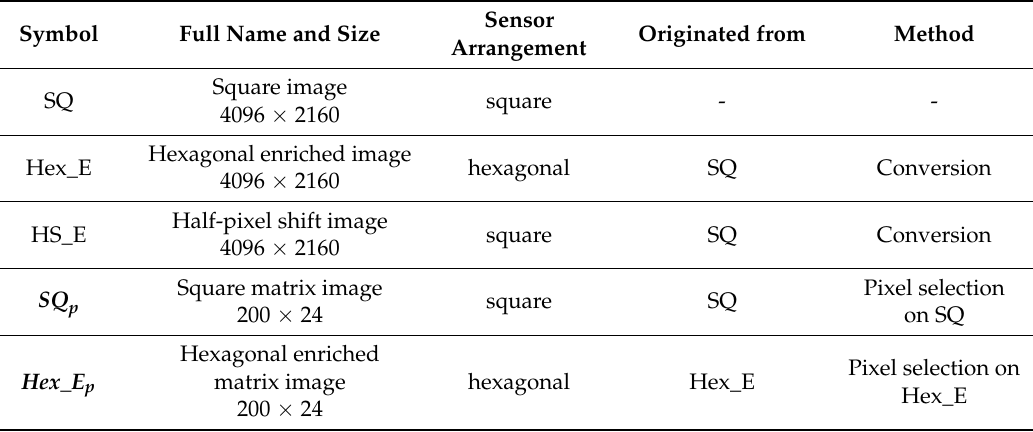
Figure 5. The flowchart to discuss and analyze the obtained results. Table 2. Description of used symbols.